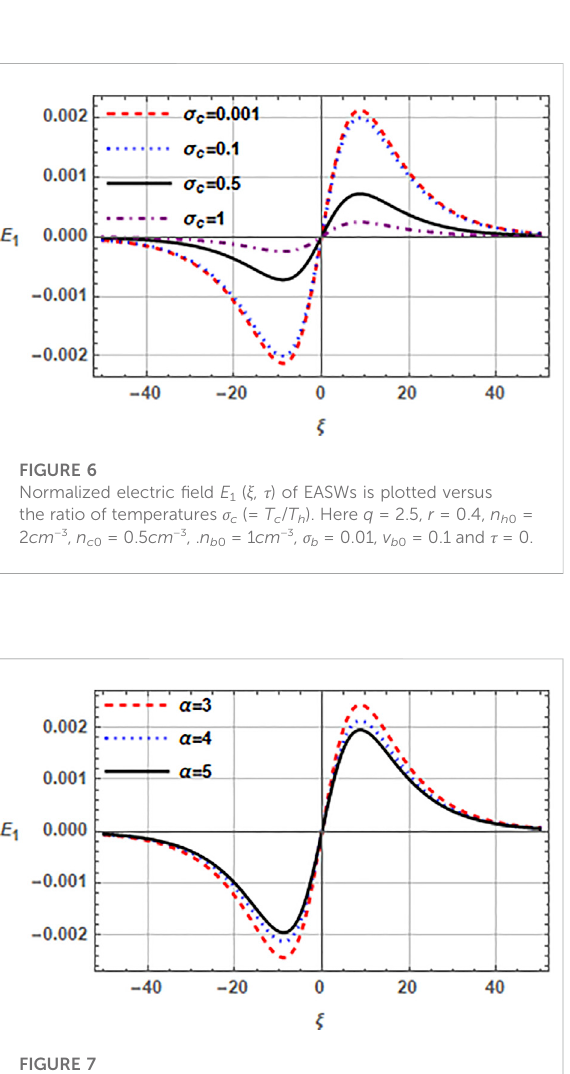
FIGURE 7 Variation of normalized electric fi eld E 1 ( ξ , τ ) of EASWs is plotted versus the ratio of densities α (= n h 0 / n c 0 ). Here q = 2.5, r